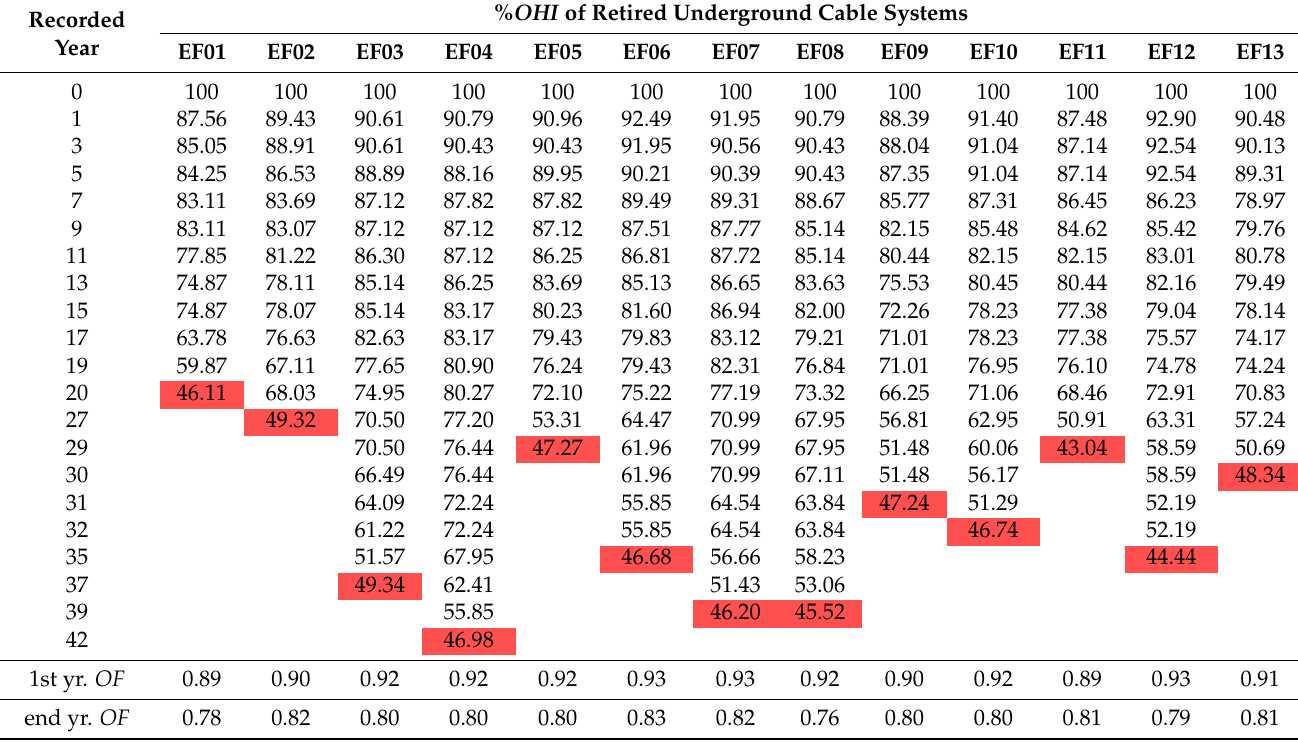
Table 6. Statistical % OHI records of 13 retired underground cable systems.